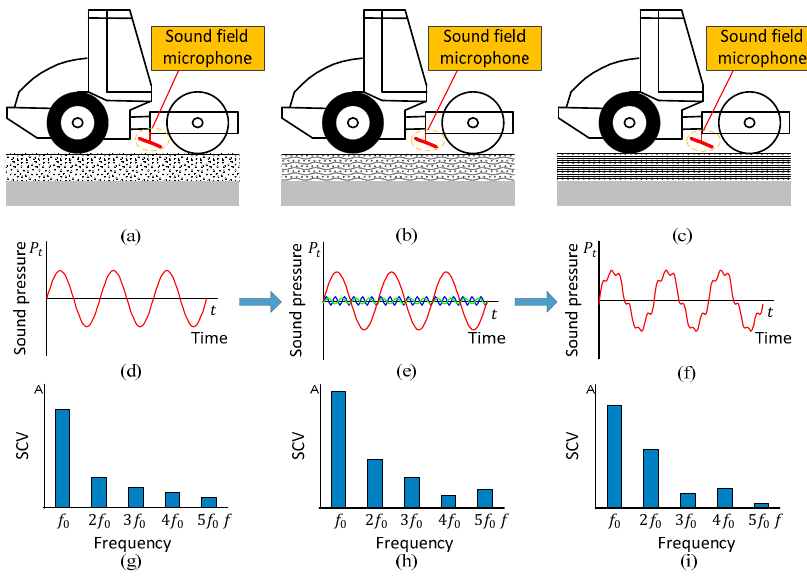
Figure 10. Illustration of changes in sound pressure and SCV with increasing ground stiffness.